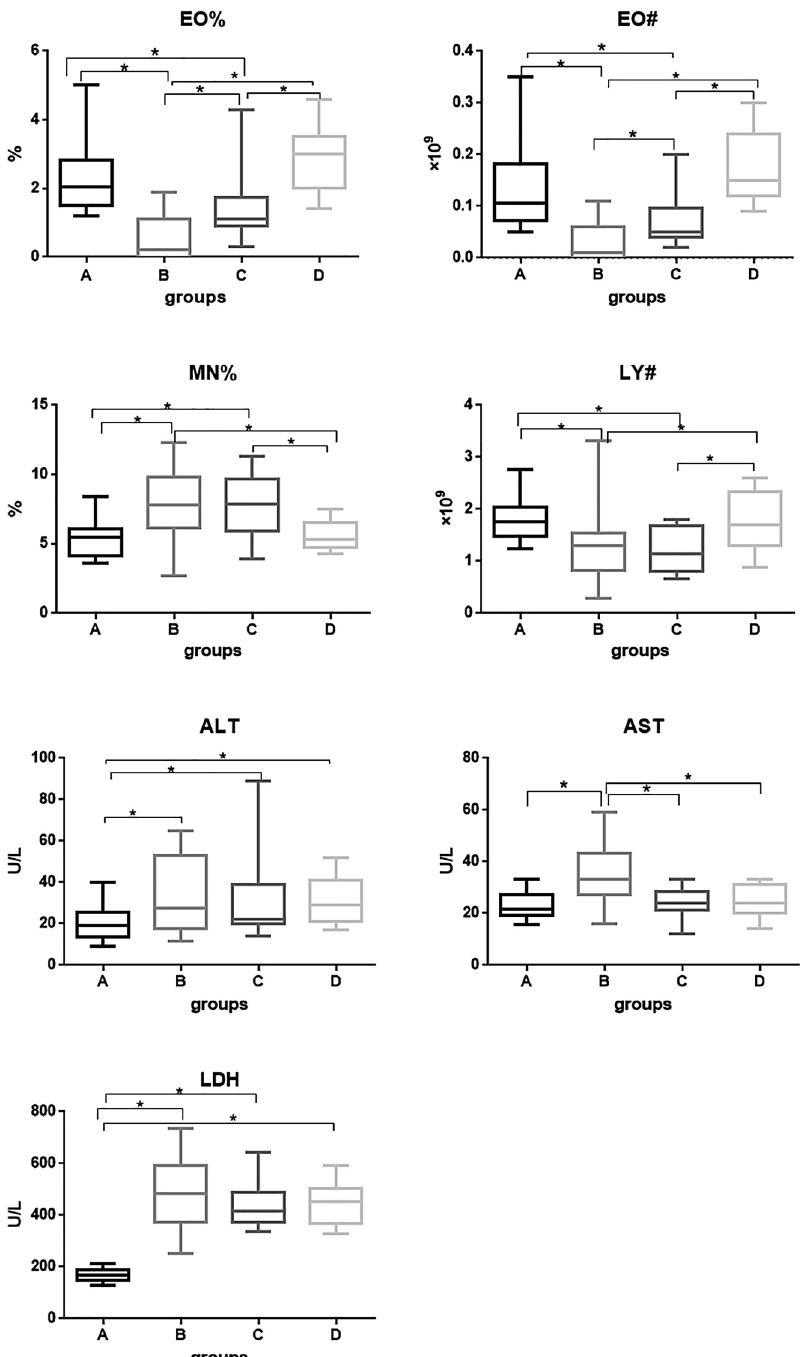
Figure2: ComparisonofthebloodindicesEO %,EO#,MN%,LY#,ALT,AST,andLDHatthe timeofadmission,discharge,andfollow-up and in healthy